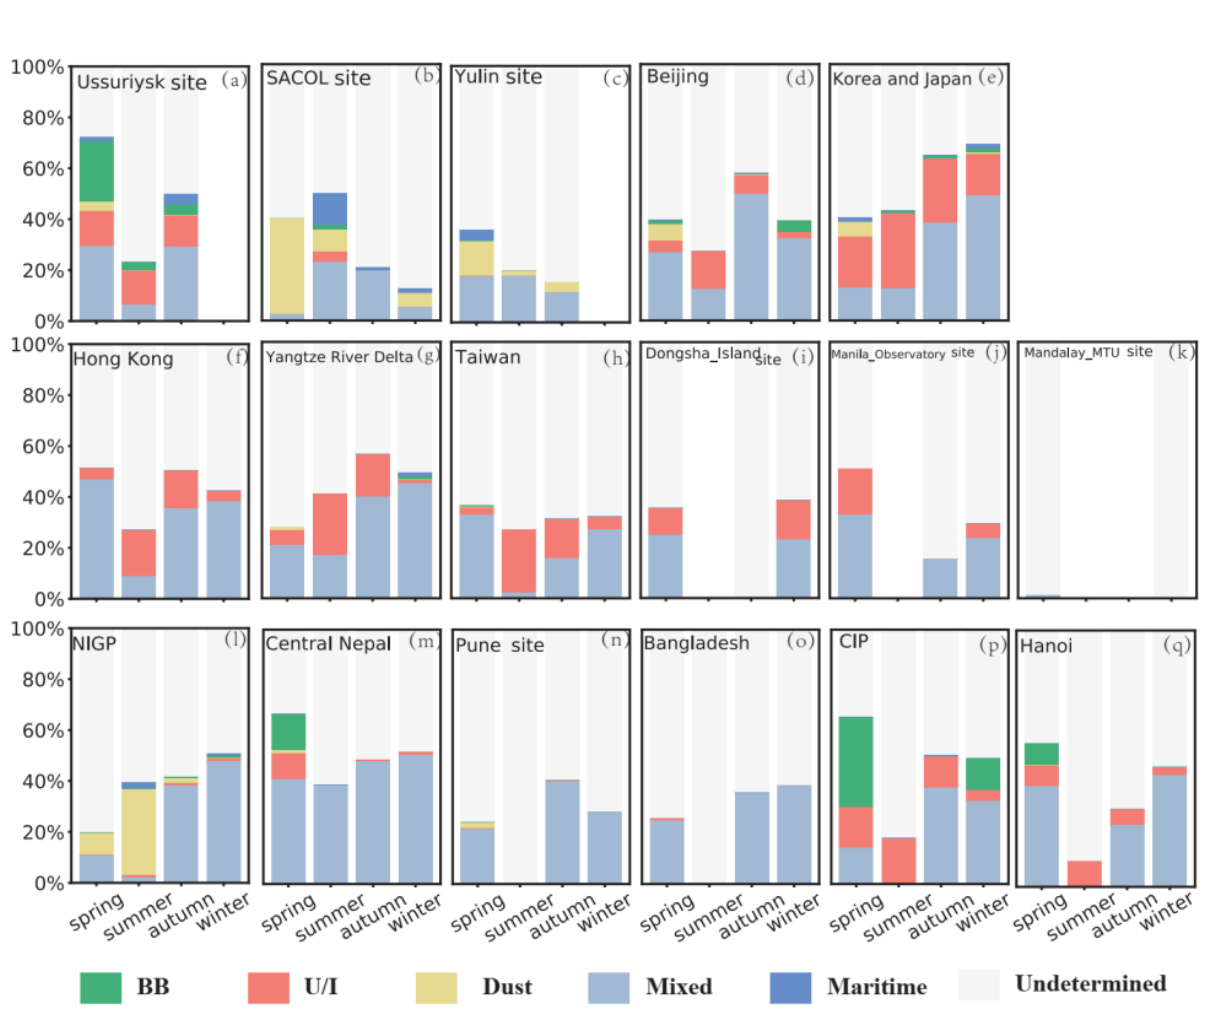
Figure 5. The percentages of different types of aerosols in various sub-regions identified through the MD method.